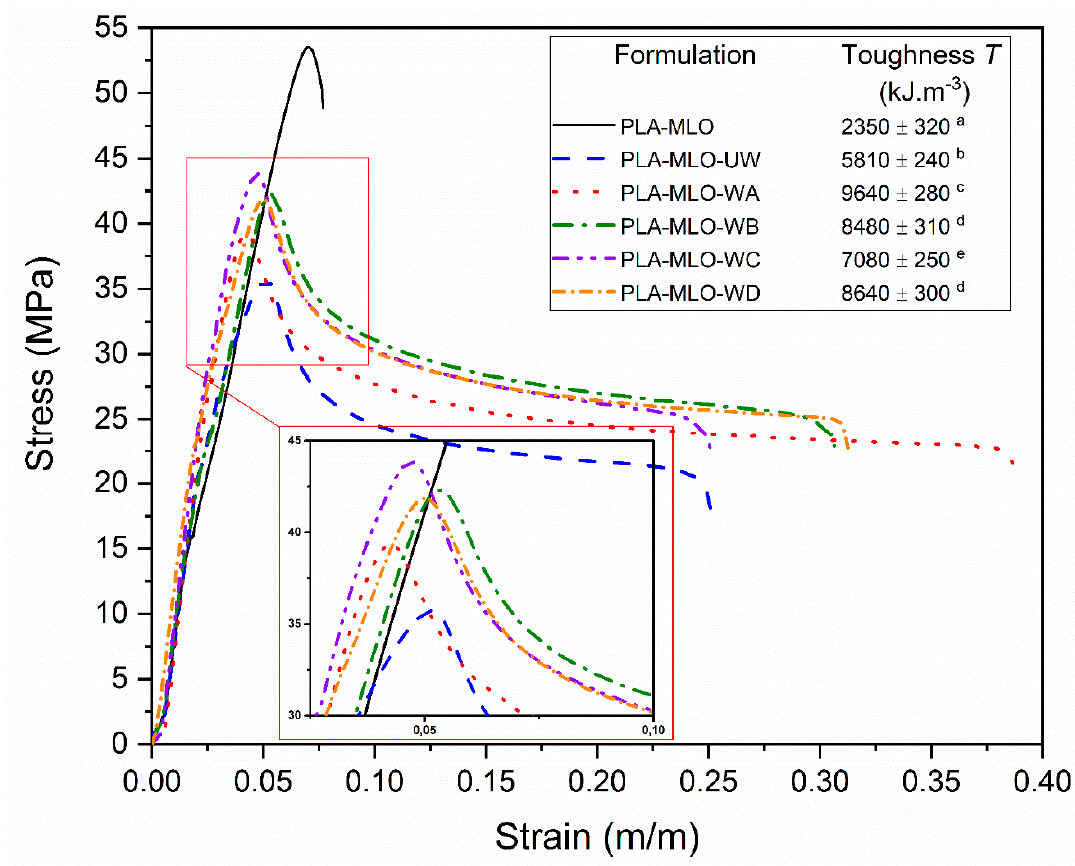
Figure 5. Typical stress–strain curves of PLA–wool FRP, and its corresponding toughness values. a–e Different letters show statistically significant differences between formulations ( p < 0.05).